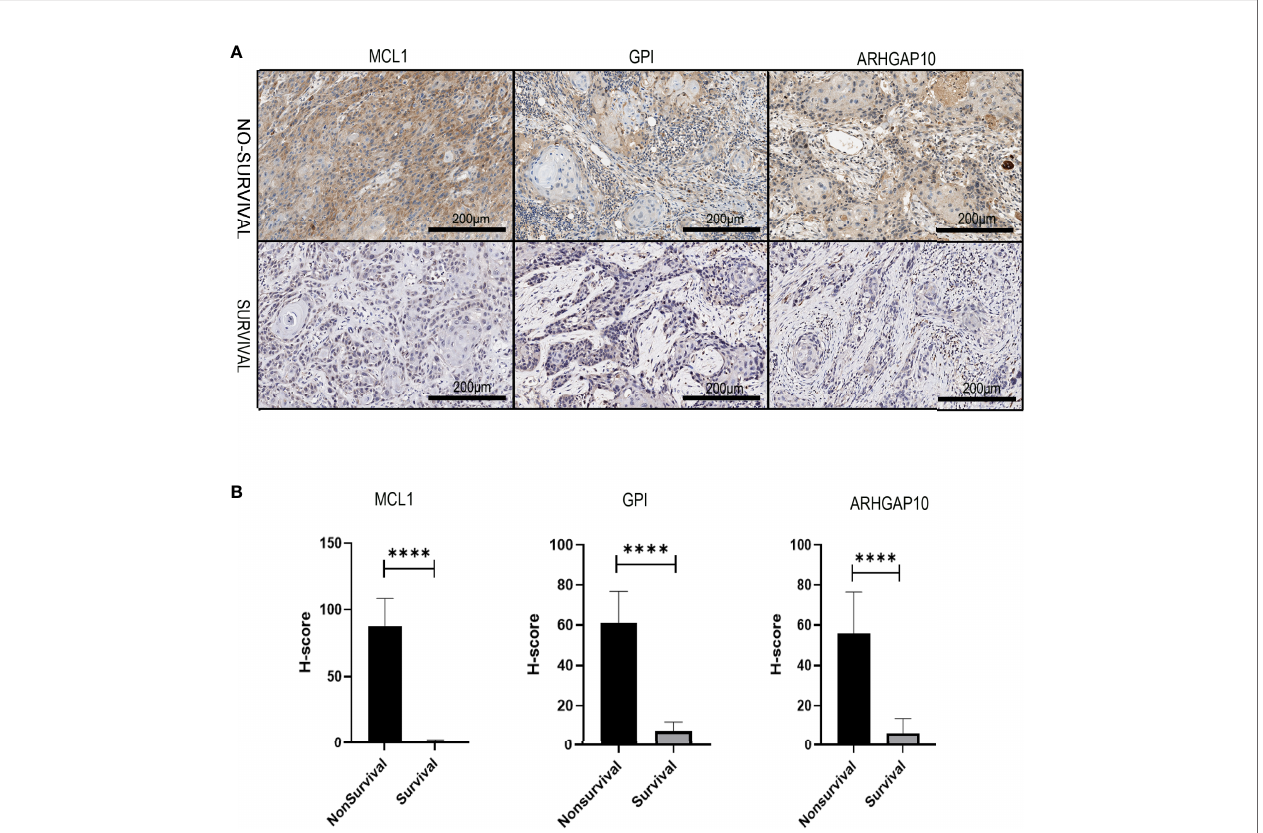
FIGURE 10 | The experiment validation of the apoptosis-related prognostic gene model. (A) The protein expressions of three apoptosis-related prognostic genes were dramatically different in dead and alive patients who had oral cancer 3 years ago. (B) Corresponding H-score of protein expression of three apoptosis-related prognostic genes. **** means p <